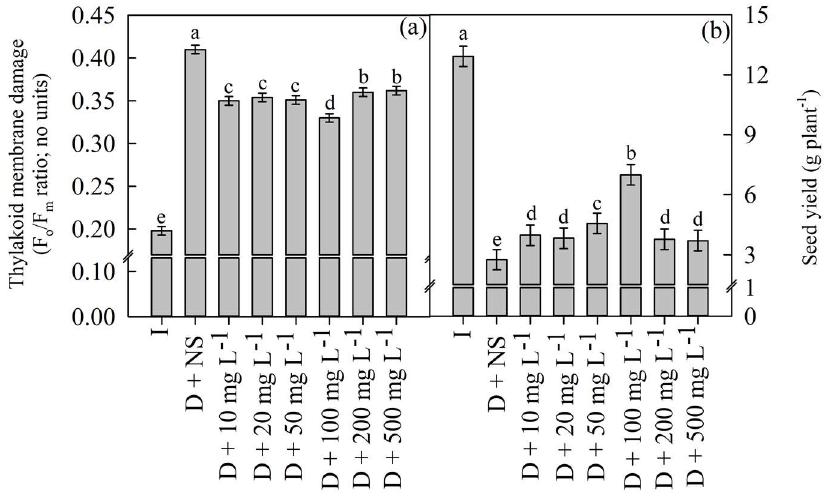
Figure 2. Optimization of nanoceria concentration for foliar spray in mungbean. ( a ) Thylakoid membrane damage (Fo/Fm ratio) and ( b ) seed yield (g plant − 1 ) under irrigated and drought-stress conditions. Each value of thylakoid membrane damage is the mean ± SD of 20 independent measurements (5 replicates and 4 observation times), and seed yield is the mean ± SD of 10 independent measurements (10 replicates). Means with different letters are significantly different at p ≤ 0.05.